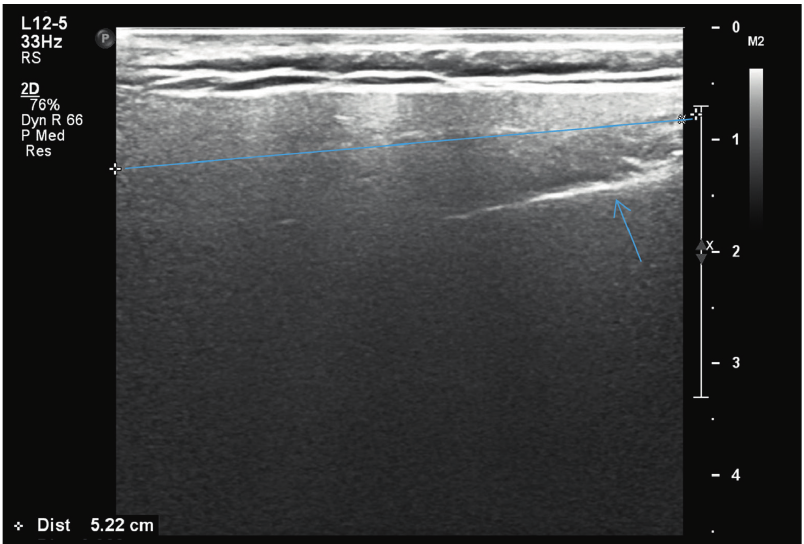
Figure 1: Measurement of length of right parotid gland of patient with HbA1c 9.7.